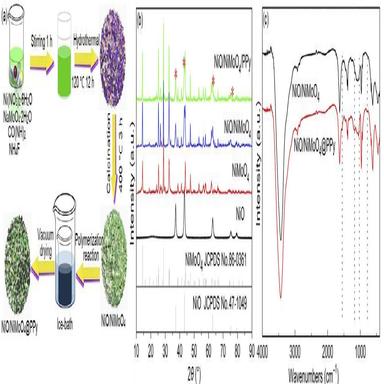
(Color online) Synthesis and characterization of NiO-based composites. (a) Schematic diagram of the synthesis for porous spherical NiO@NiMoO4 and NiO@NiMoO4@- PPy nanoarchitectures, (b) XRD patterns of NiO, NiMoO4, NiO@NiMoO4 and NiO@NiMoO4@PPy, (c) FT-IR of NiO@NiMoO4 and NiO@NiMoO4@PPy.